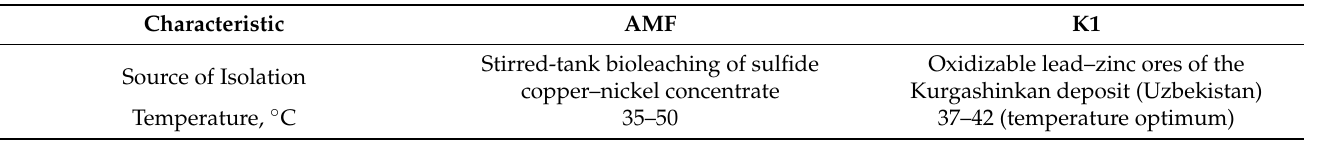
Table 3. Main characteristics of growth and substrate oxidation of Al. tolerans AMF isolated from a bioreactor during bioleaching of the copper–nickel concentrate in comparison with phenotypic features of Al. tolerans K1 T